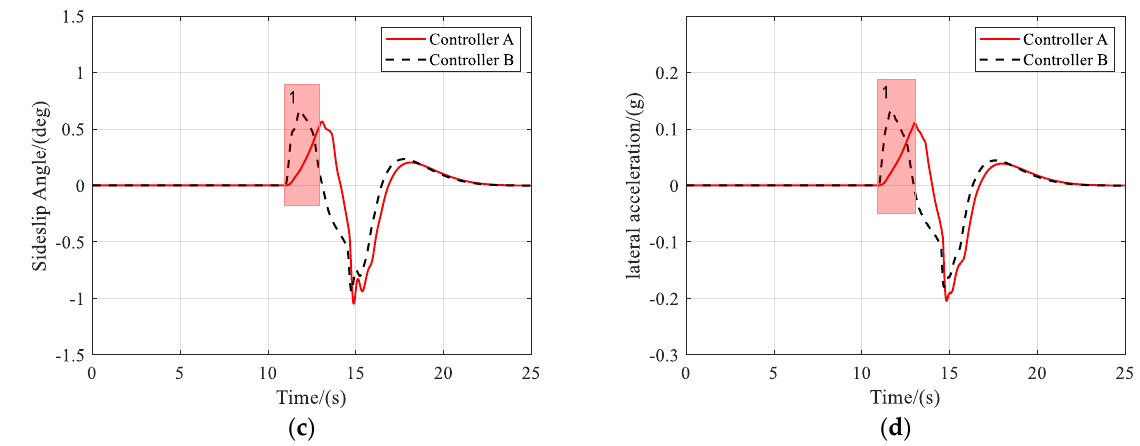
Figure 5. Scenario 1: Simulation results at 36 km/h. ( a ) Vehicle trajectory, ( b ) the actual front wheel angle, ( c ) sideslip angle, and ( d ) lateral acceleration.